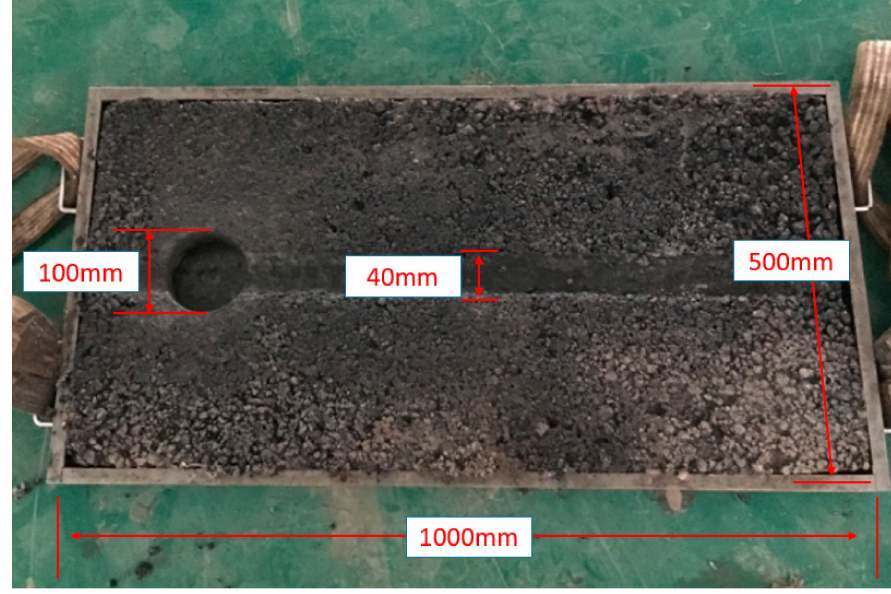
Figure 3. Specimen size and the core drilling.